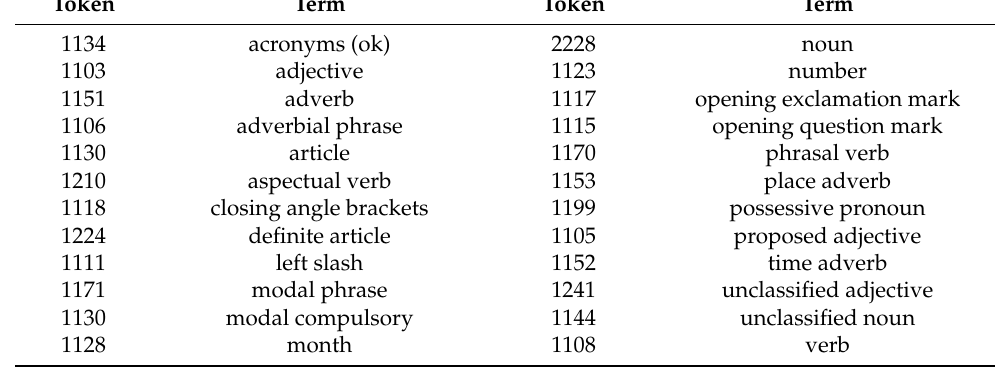
Table 1. Sample table of tokens from Reuse SE tools.